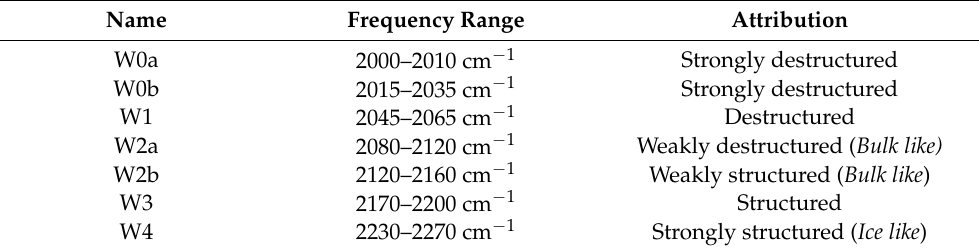
Figure 8. Representative WAB fitting in terms of five components ( left panel ), a sample of trehalose:NaClO 4 2:1, reported from [44]), and seven components ( right panel ), a sample of myoglobin-lactose at S/P = 40). In both figures, the background has been subtracted, but the band is not normalized. Table 4. Frequency intervals and attributions for WAB sub-bands and